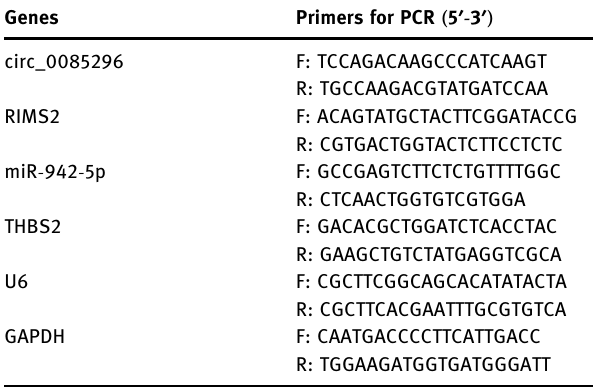
Table 1: Primer sequences for qRT -